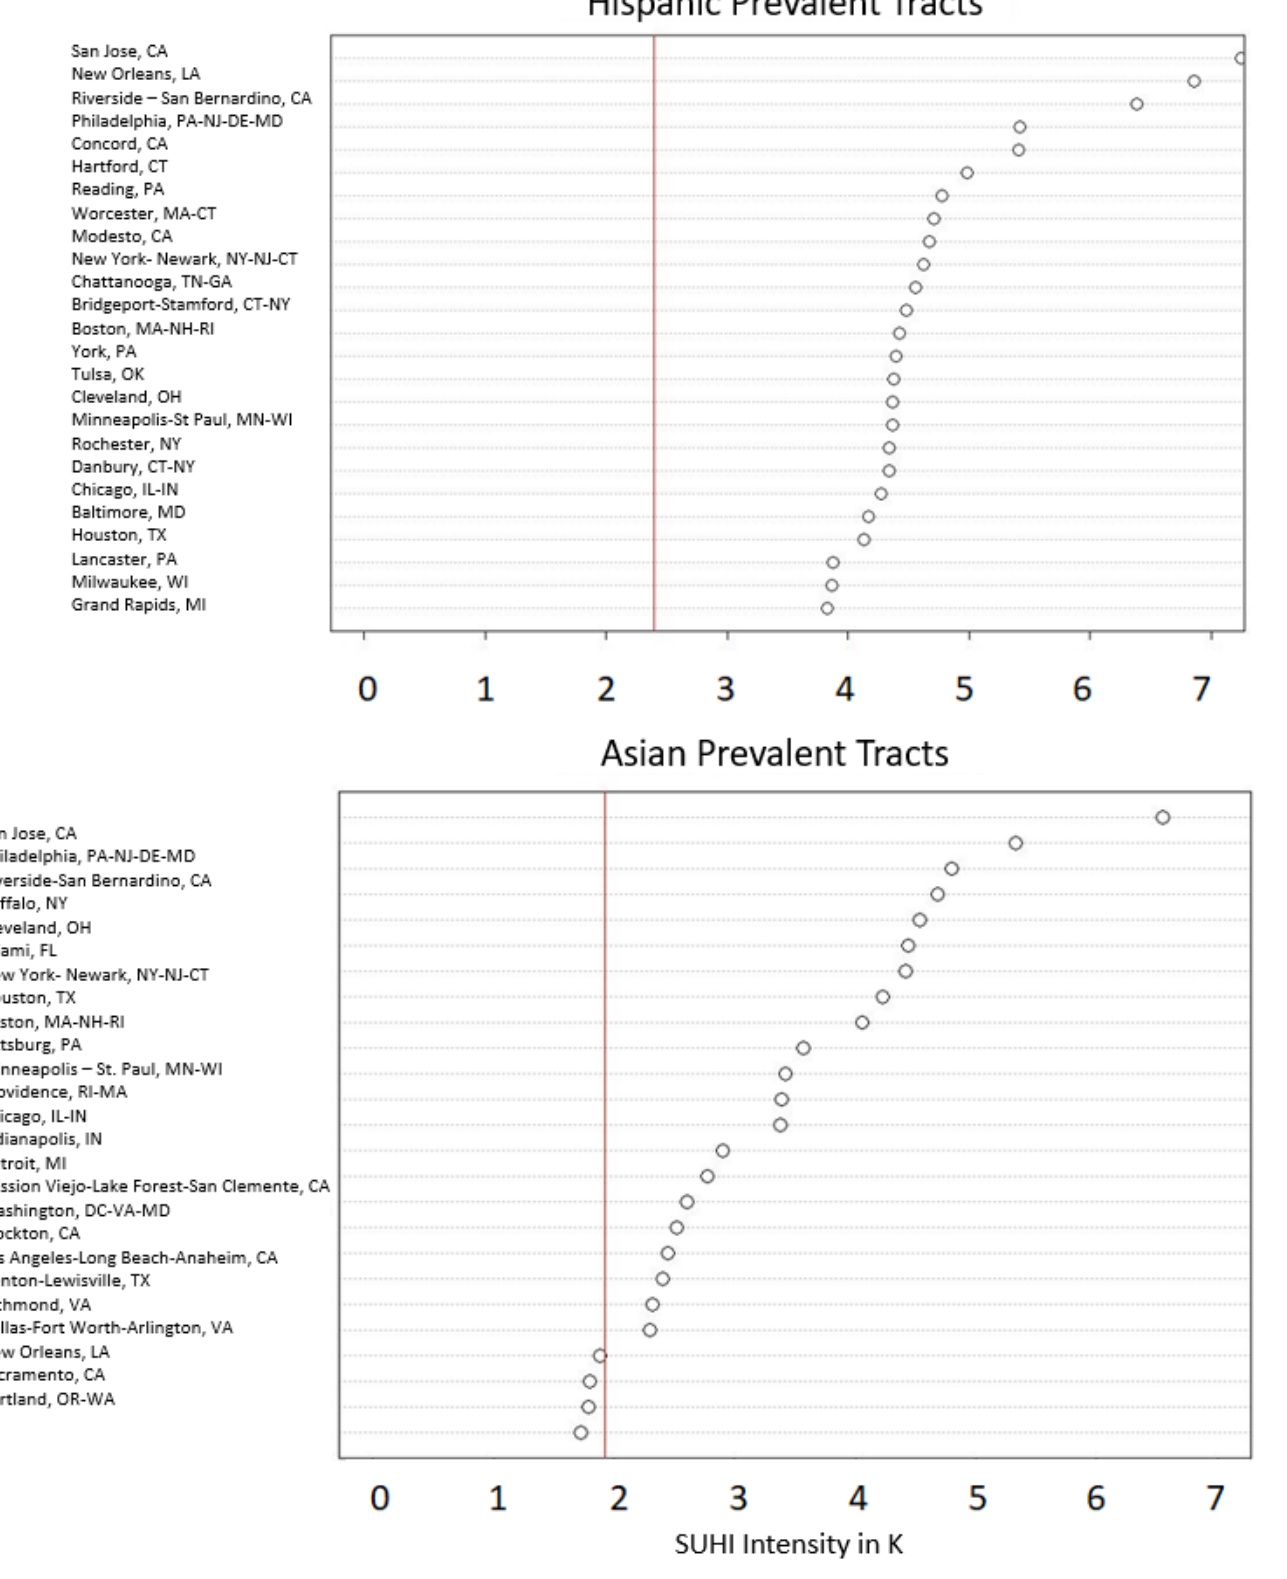
Figure 5. Top 25 cities ranked by highest SUHI intensity for census tracts classified as Hispanic and Asian prevalent. Circle is the average SUHI intensity for the prevalent tracts of the respective city. Red vertical line represents the overall SUHI intensity average for the prevalent tracts of the demographic group.